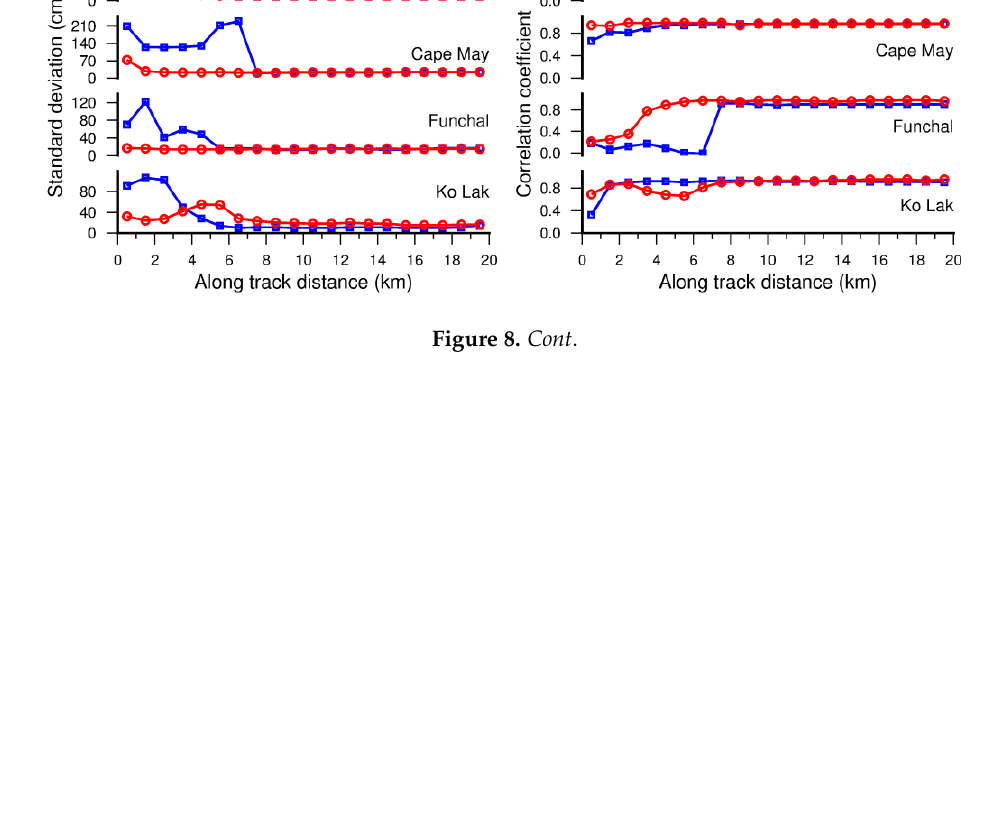
Figure 8. Standard deviation ( a ) correlation coefficient ( b ) valid data percentile ( c ) and invalid cycle number ( d ) of ALES product ( blue ) in the four study regions. For comparison, the results of DW-TR ( red ) are also shown in the figure.